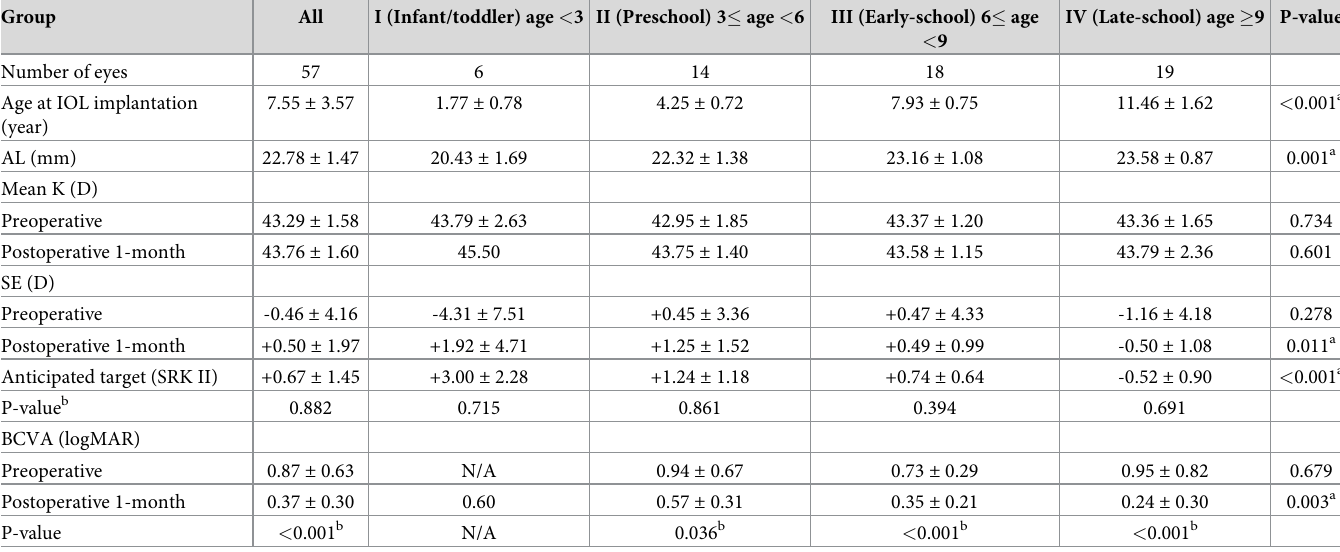
Table 2. Ocular biometric findings of pseudophakic eyes at the time of IOL implantation and one-month postoperatively.